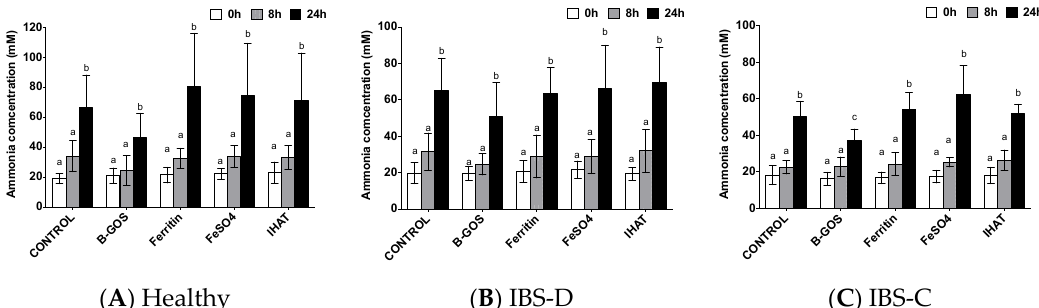
Figure 9. Ammonia production in pH-controlled batch cultures inoculated with faeces from ( A ), Healthy donors; ( B ), IBS-D donors and ( C ), IBS-C donors. Values are mean ± SD of five independent experiments. Different label letters (a, b) indicate significant differences between time-points. There were no significant differences between the test compounds and the control condition (i.e., gut model media only, with no additional test substrate), p < 0.05.